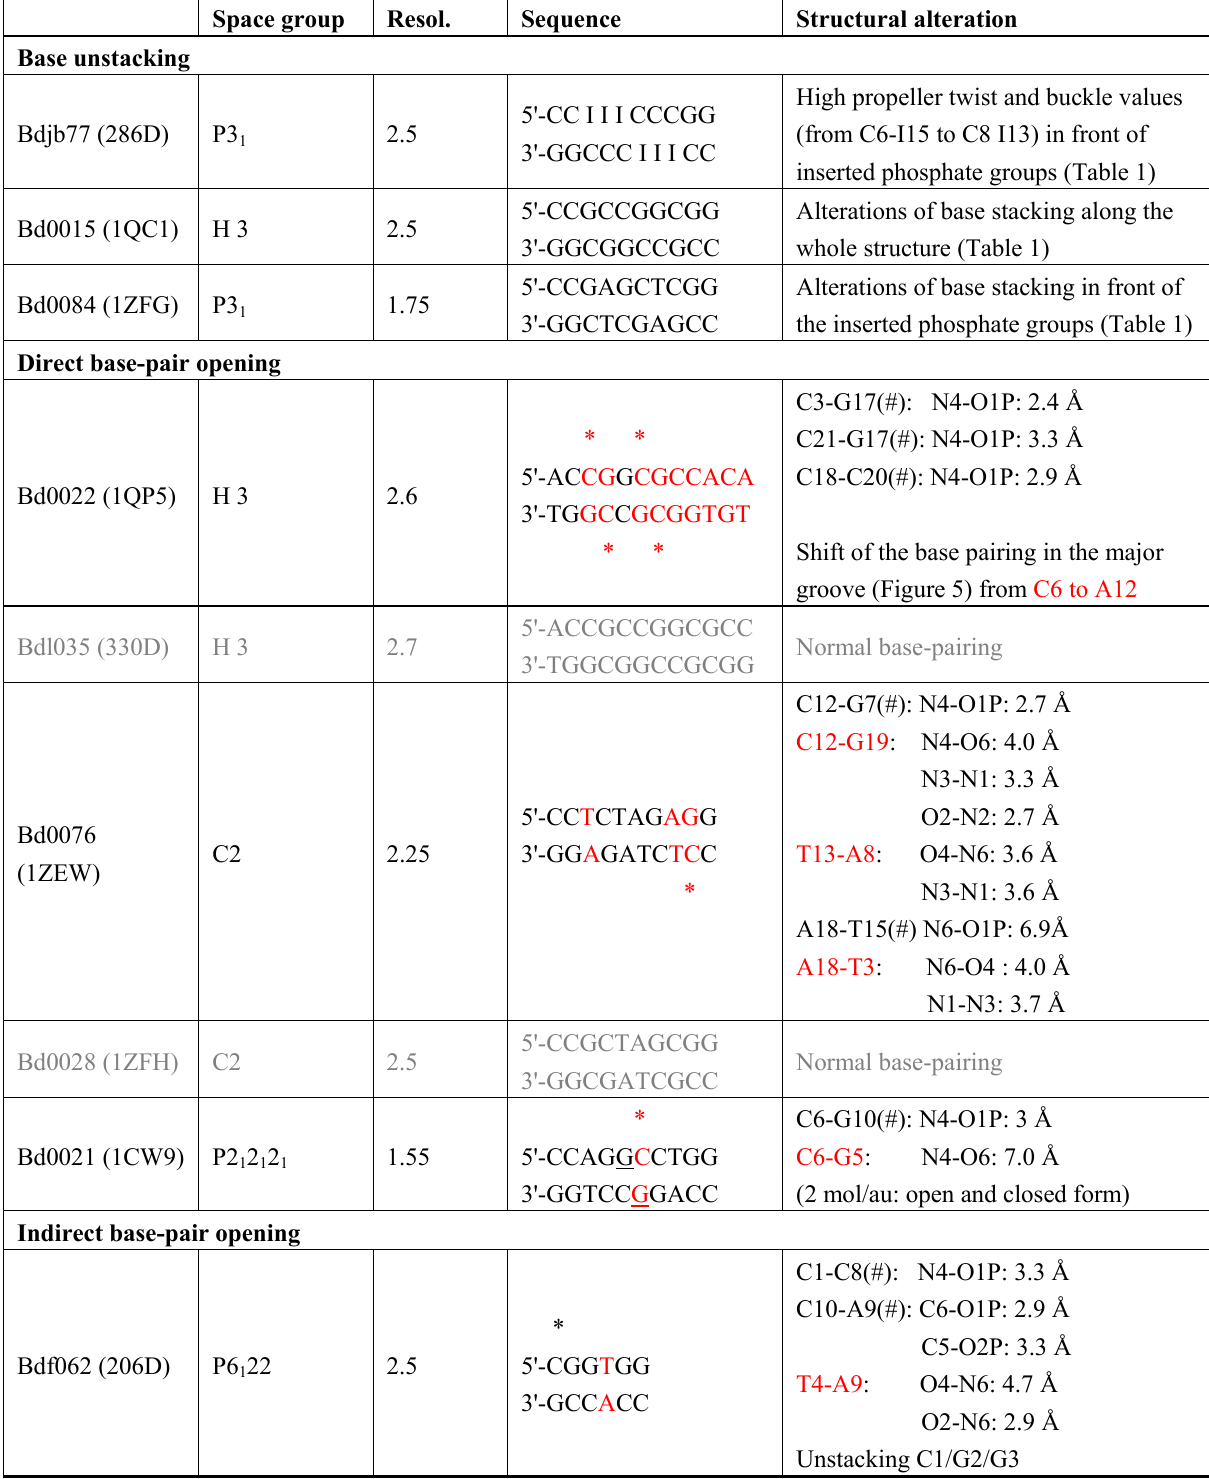
Table 2. Direct and indirect base pair opening induced by DNA-DNA interactions. The star denotes the cytosine that makes an hydrogen bond with the inserted phosphate group. The # denotes a residue from a symmetry related molecule. The base-pairs represented in red are partially